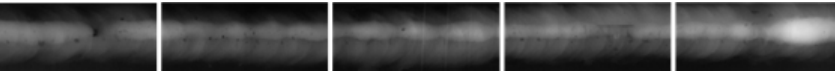
Figure 5. Divided radio-graphic testing